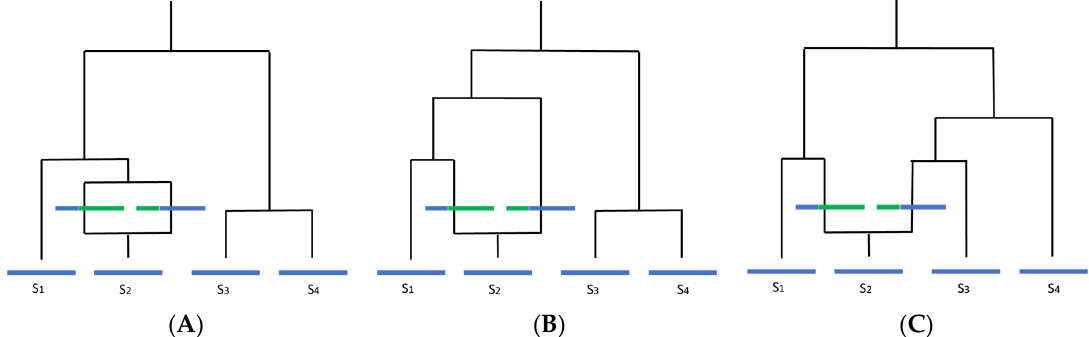
Figure 2. How recombination affects molecular clock-like processes and interpretation of the underlying phylogeny (adapted from Hein et al., 2005). Blue indicates ancestral material, green indicates non-ancestral material. Assuming there is only one recombination event in the history of the sample, to the left of the recombination event, there is one local tree, and to the right, there is another local tree. This can alter the inferred overall phylogeny in three ways: ( A ) looking back in time, if the two recombining sequences merge with each other before coalescing with any other sequence, the trees will be identical and the recombination event will likely be undetectable; ( B ) if one of the recombining sequences coalesces with a difference sequence (in this case, S1) before merging with the other recombining sequence, the unrooted tree topology will remain the same, but branch lengths will change; ( C ) if two or more sequences coalesce with the recombining sequences before the two recombining sequences merge, the tree topology will change.